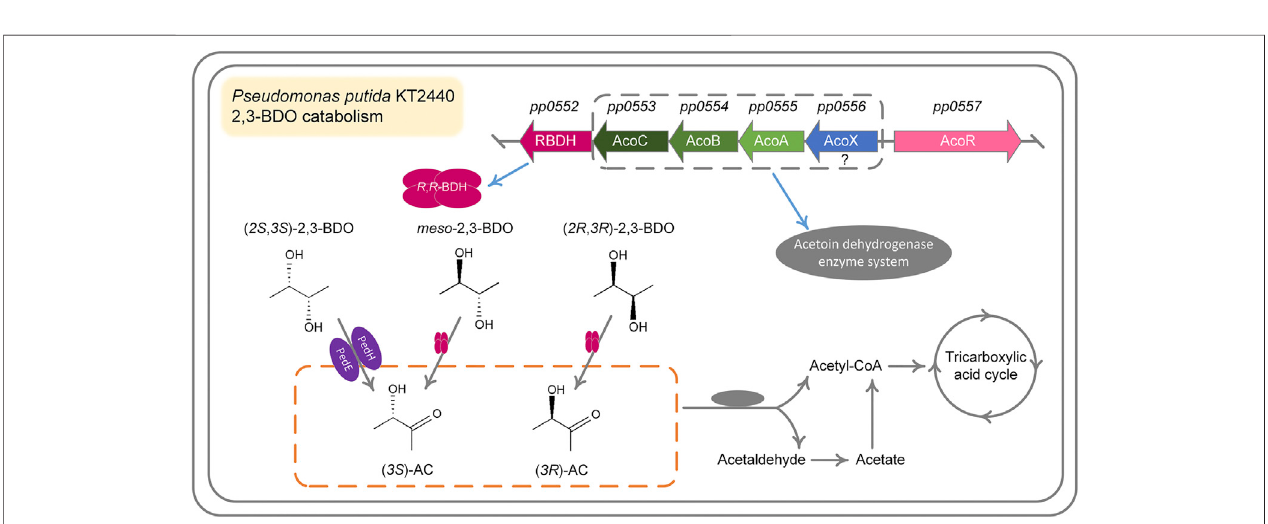
FIGURE 7 | Proposed mechanism for 2,3-BDO catabolism in P. putida KT2440. meso -2,3-BDO and (2 R ,3 R )-2,3-BDO are dehydrogenized by R , R -BDH to (3 S )- AC and (3 R )-AC, respectively. Dehydrogenation of (2 S , 3 S )-2,3-BDO to (3 S )-AC is catalyzed by two PQQ-EDHs, PedH and PedE encoded by pp2679 and pp2674 , respectively. (3 S )-AC and (3 R )-AC are subsequently cleaved by AoDH ES to acetyl-CoA and acetaldehyde for further metabolism.